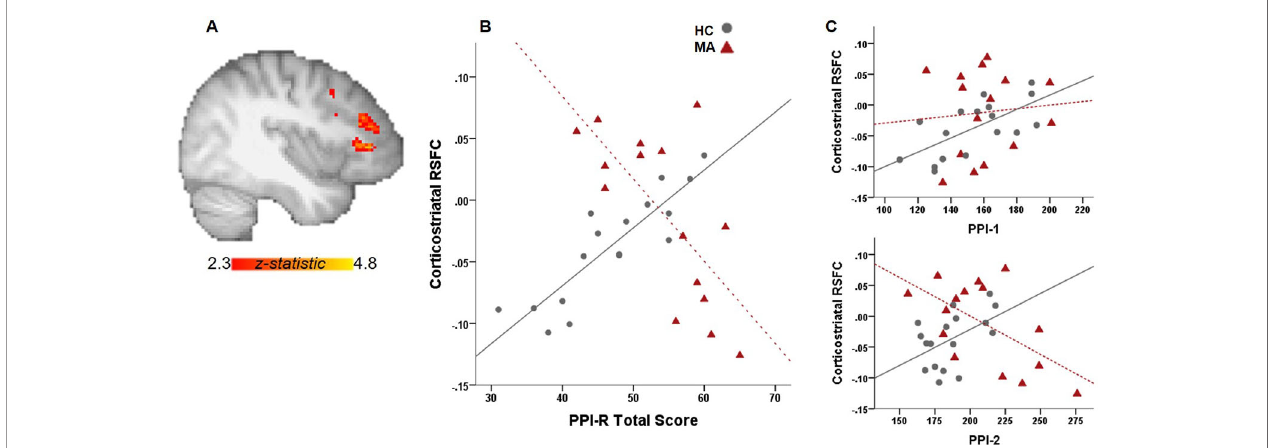
FIGURE 1 | Relationship between PPI total scores and RSFC. (A) Whole-brain connectivity analysis with a ventral striatal seed show signi fi cant group interactions with PPI-R total scores on corticostriatal connectivity. (B) Scatter plot illustrates the relationship between RSFC and PPI-R total scores for each group. (C) Signi fi cant group interactions on corticostriatal RSFC with PPI-R subscales.